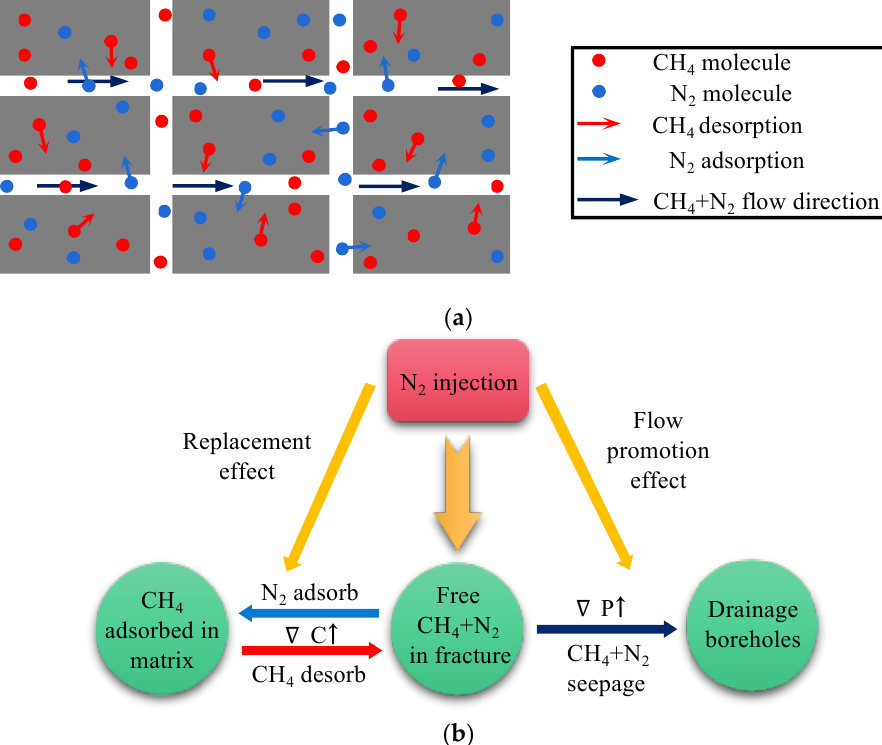
Figure 3. The process of nitrogen injection drainage: ( a ) Schematic diagram of the N 2 -ECGD pro- cess; ( b ) Illustration of the N 2 -ECGD mechanism.